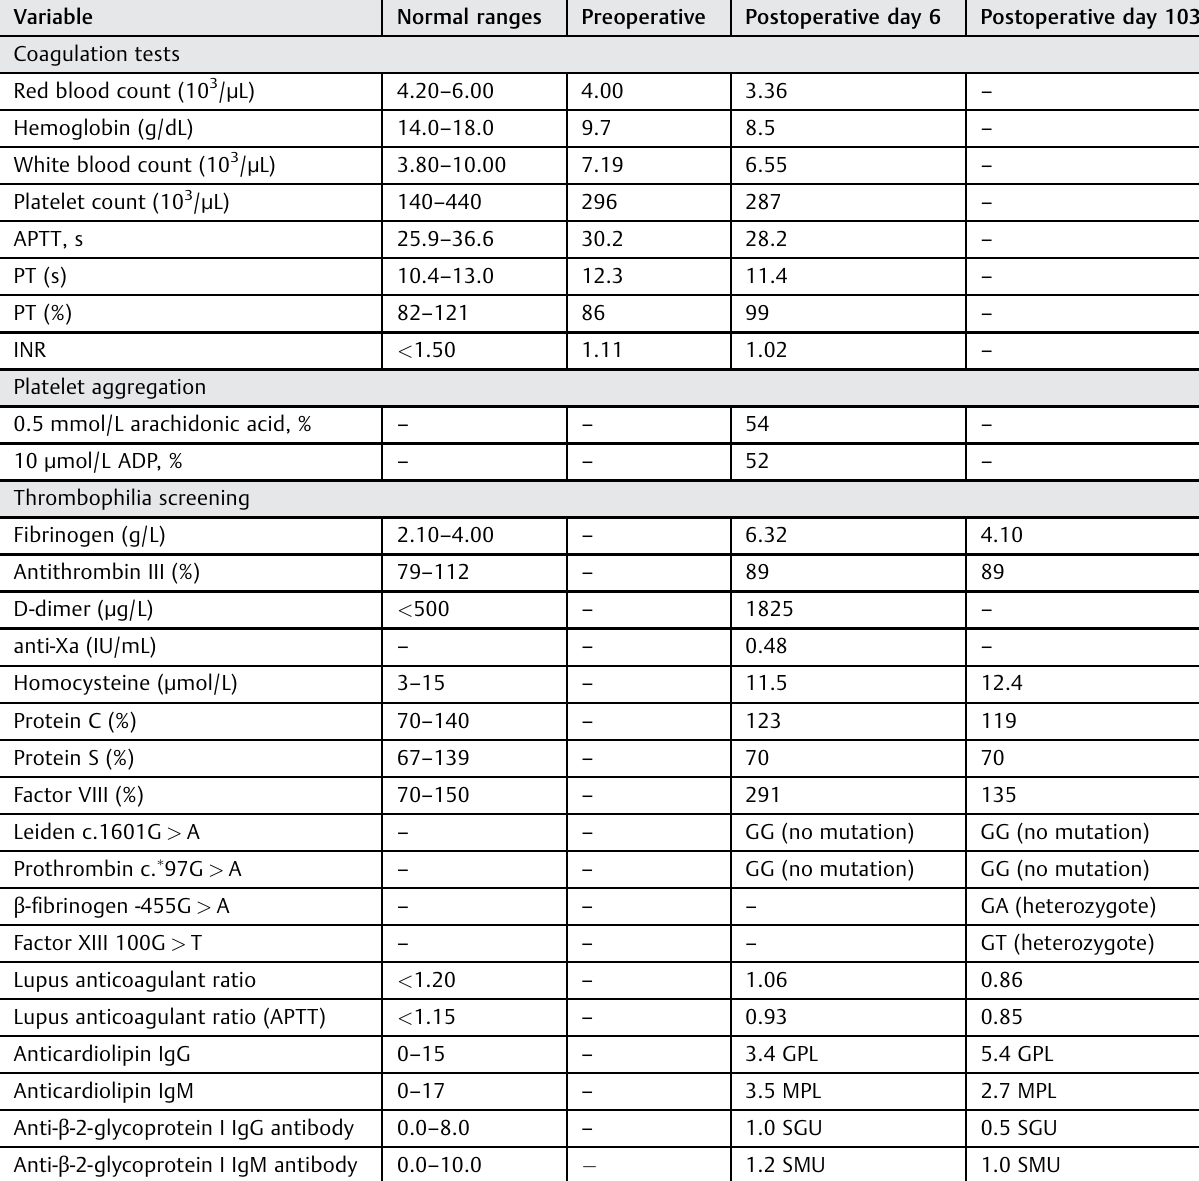
Table 1 Results of initial and follow-up laboratory